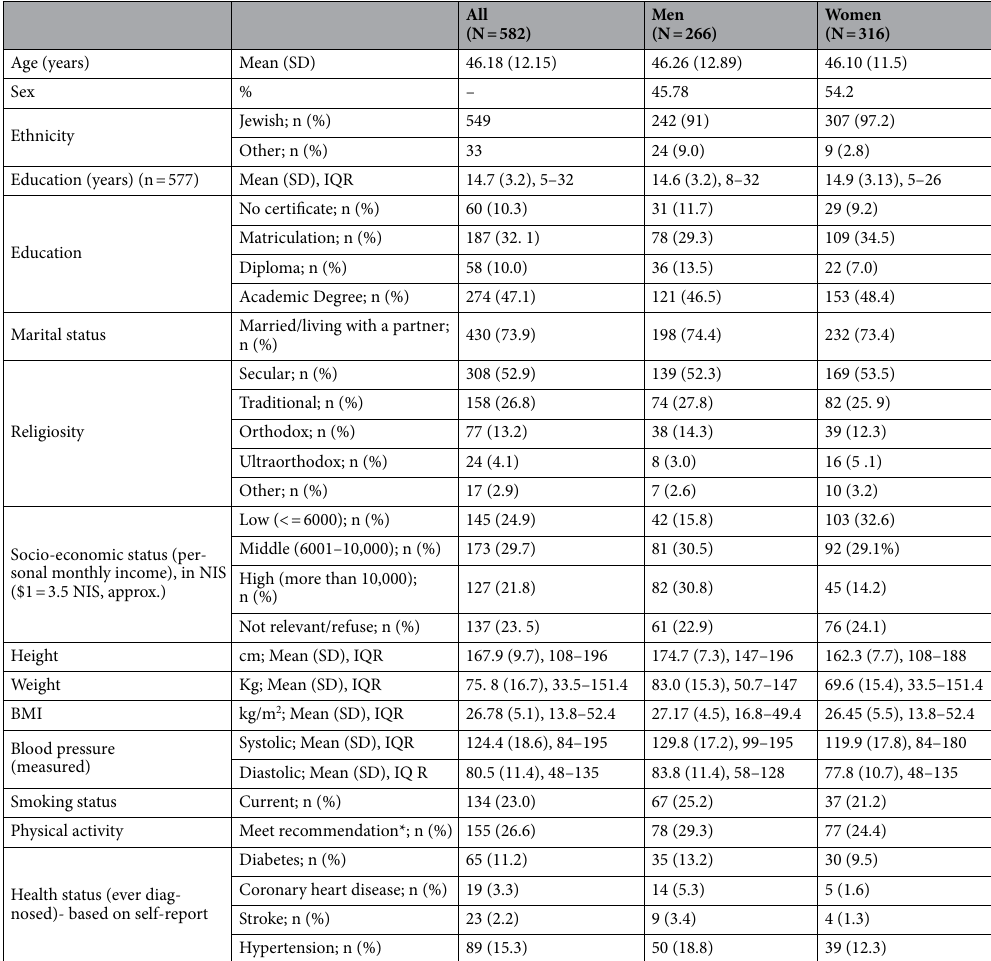
Table 1. The socio-demographic and physical characteristics of the sample with urine tests. BMI Body Mass Index, IQR Inter Quartile Range, NIS New Israeli Shekels, SD Standard Deviation. *As recommended by